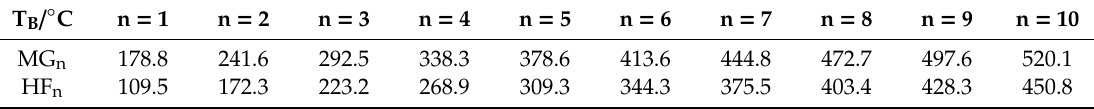
Table 7. Calculated normal boiling points (T B ) of MG 1–10 and HF 1–10